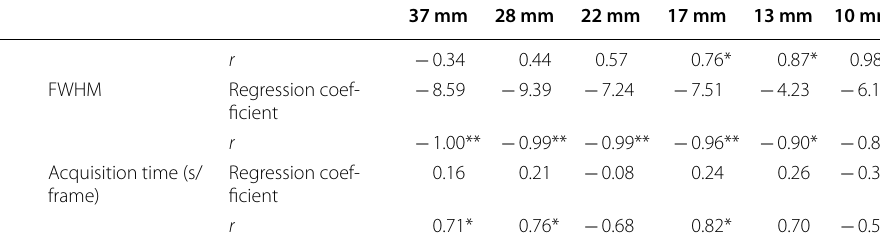
Fig. 3 Impacts of subsets on RCs. a 32:1 T/B ratio; b 16:1 T/B ratio; c 8:1 T/B ratio; d 4:1 T/B ratio; RCs were calculated with 2–30 subsets; Fixed reconstruction parameters: 35 iterations, no filter, AC combination; Fixed acquisition parameters: 120 s/frame of acquisition time, 15% energy